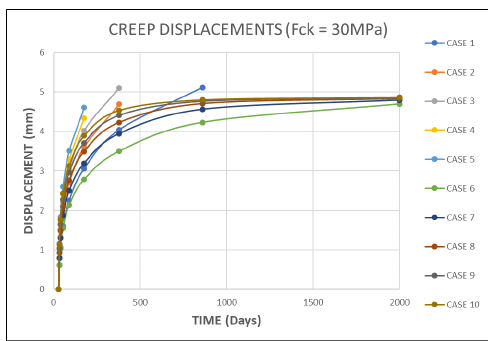
Figure 8. C30 concrete creep displacement curves.